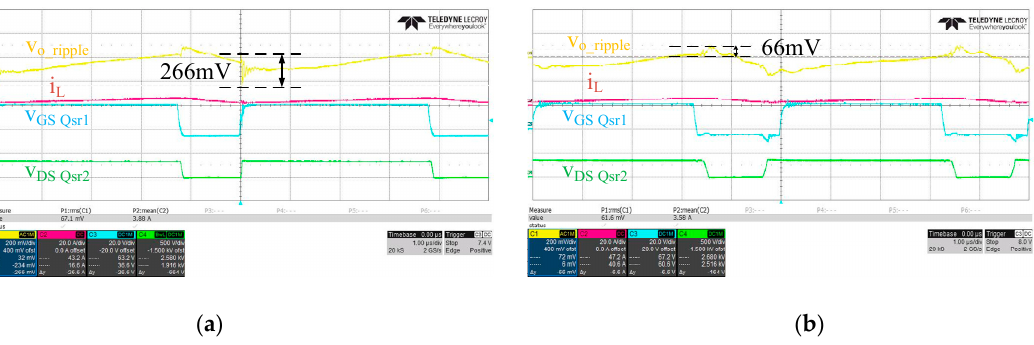
Figure 20. Switching noise performance: output voltage ripple, output inductor current waveform, Q sr 1 switch’s v GS signal and Q sr 2 switch’s v DS voltage at V O = 250 V, Io = 4 A ( a ) without peration of auxiliary circuit ( b ) with peration of auxiliary circuit (scale v o ripple (Ch1): 200mV/div; i L (Ch2): 20 A/div; v GS_Qsr 1 (Ch3): 20 V/div; v DS_Qsr 2 (Ch4): 500 V/div; time: 1 μ s/div).